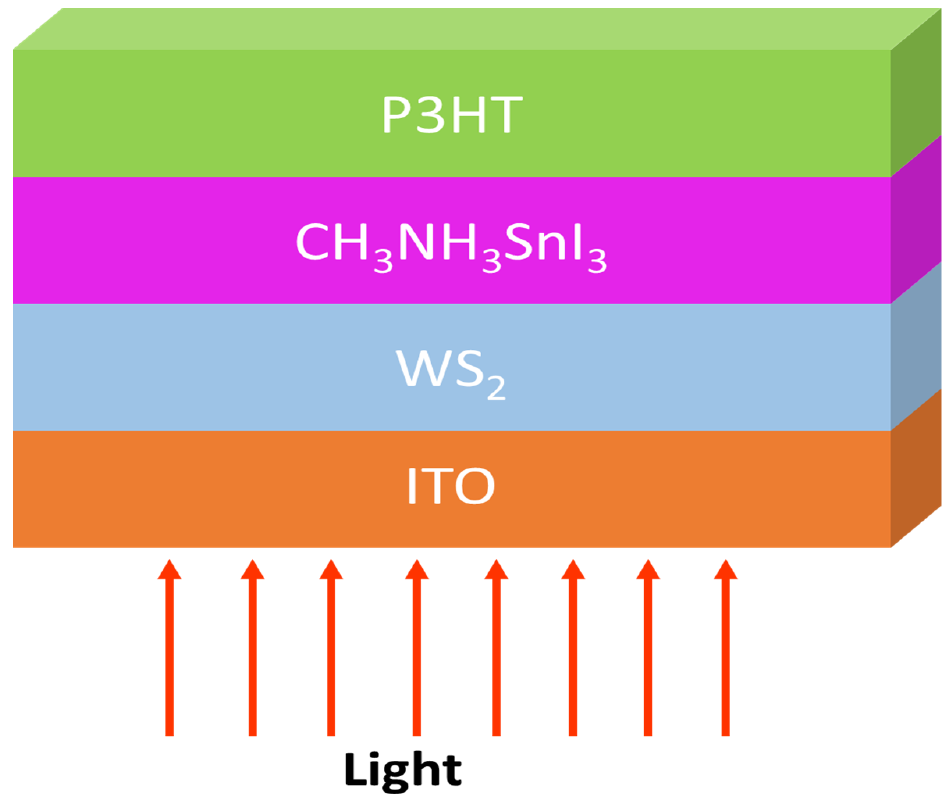
Figure 1. Schematic device structure of perovskite solar cell.